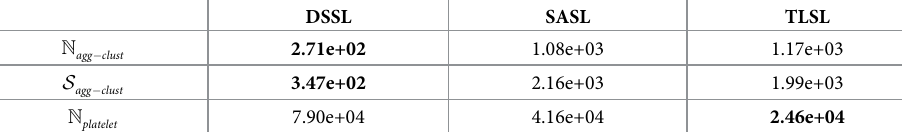
Table 4. Comparison of predictive performance of approximate ABC posterior learned via summary statistics learned using DSSL, SASL and TLSL approach based on energy score. Better predictive performance is measured by the smaller energy score